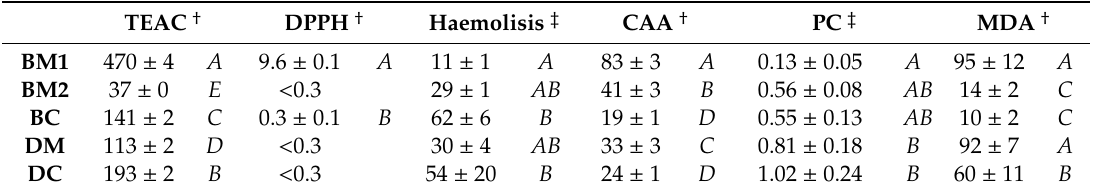
Table 3. Selected oxidative status indicators (means ± standard deviations; n = 3) for di ff erent human milk fortifiers or protein concentrates (per g of added